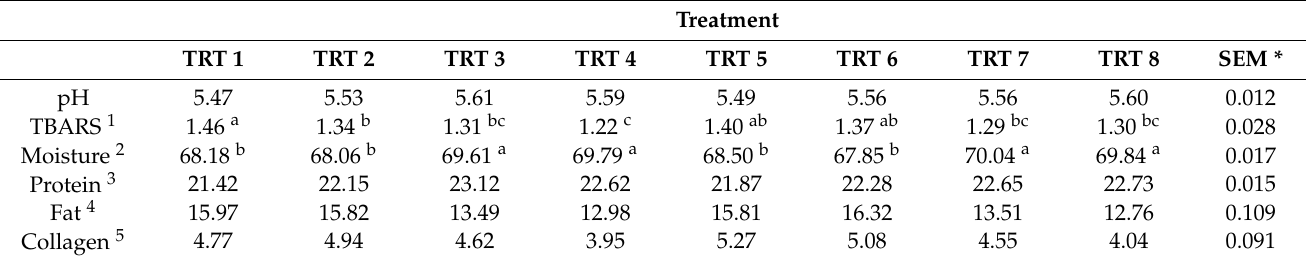
Table 2. Influence of packaging film and lean trimmings on instrumental analysis of ground beef. Treatment